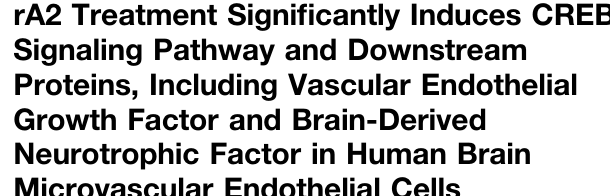
Frontiers in Pharmacology |